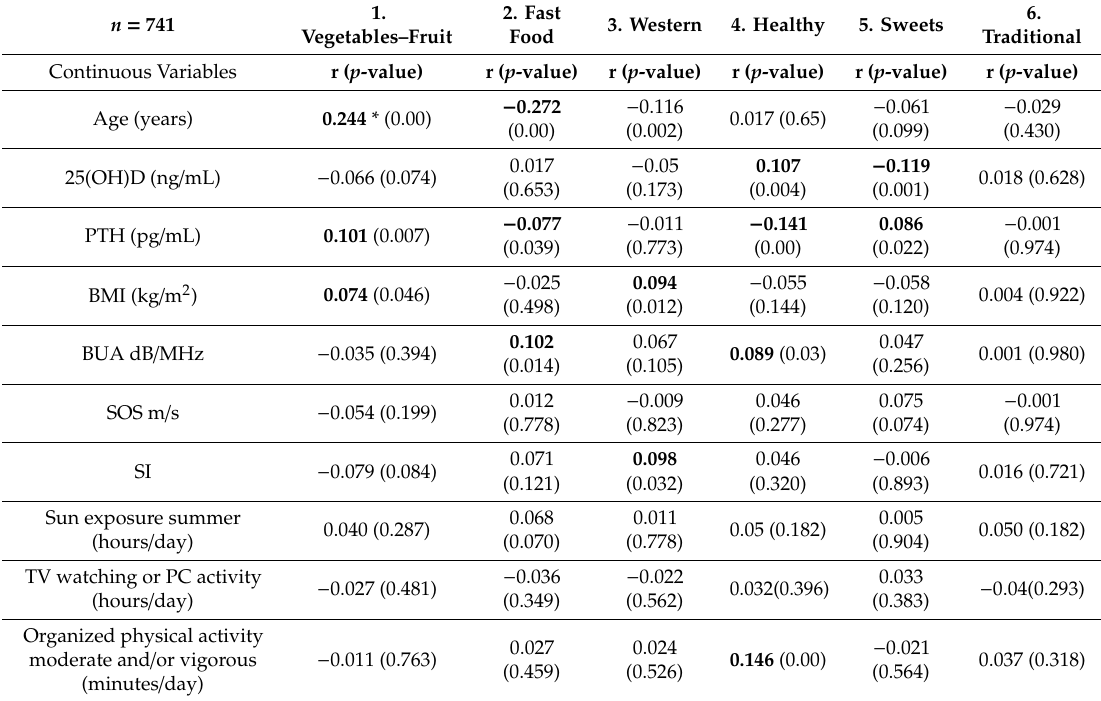
Table 3. Correlation between dietary patterns and continuous